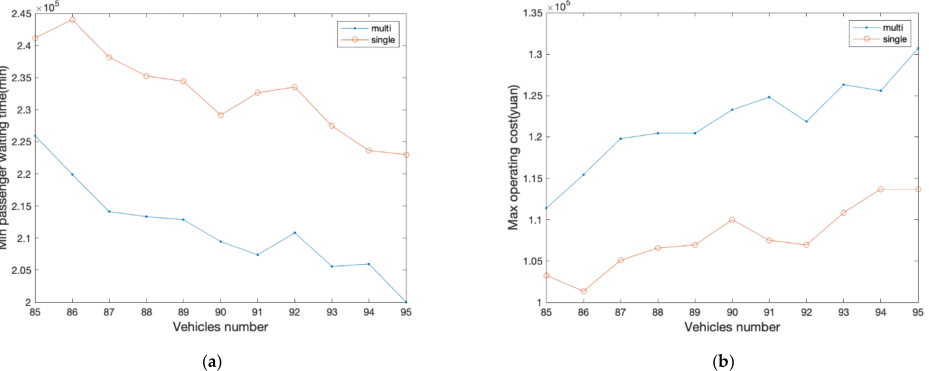
Figure 21. Comparison of results under different modes. ( a ) Minimum passenger waiting time in different modes with different vehicle numbers; ( b ) maximum operating cost in different modes with different vehicle